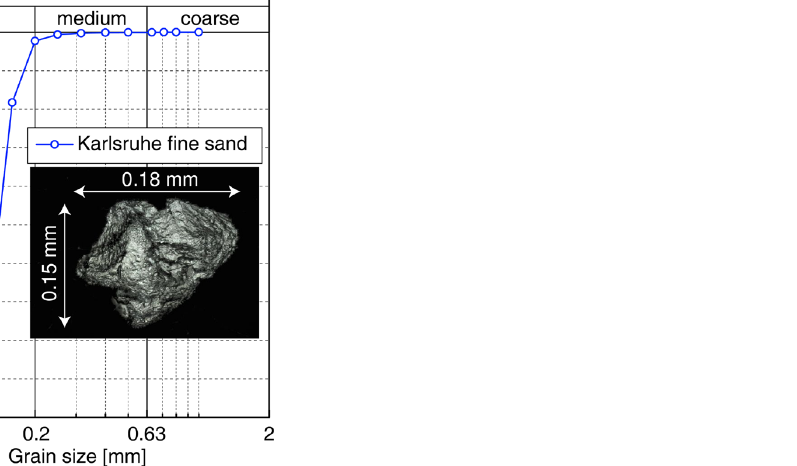
Figure 3. Grain size distribution curve after 27 of the used KFS and microscopic image of a grain out of 28